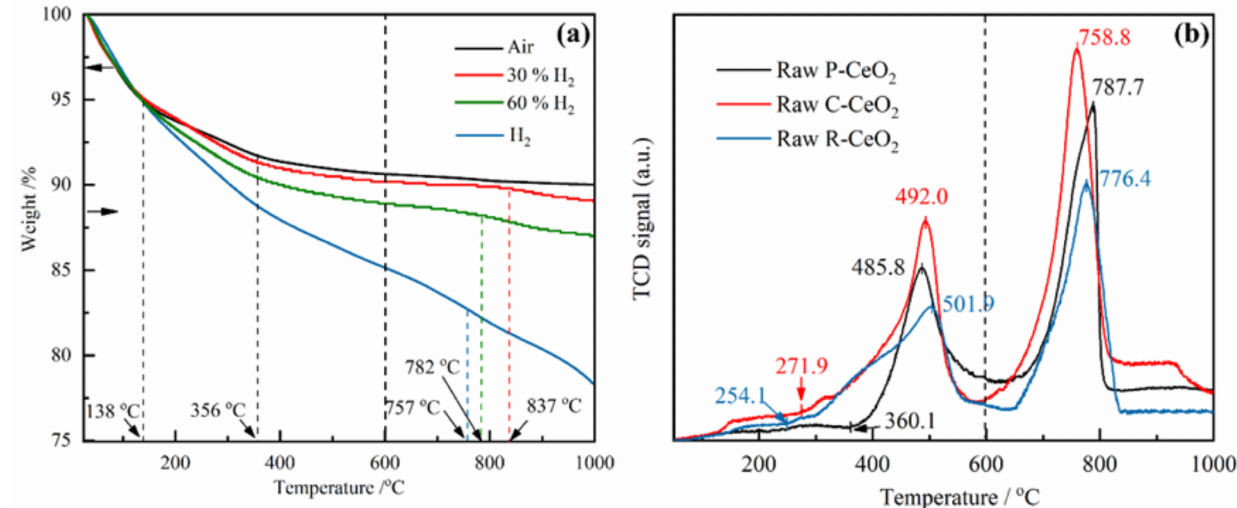
Figure 3. Thermal reduction behavior of synthesized ceria, ( a ) the thermo-gravimetric analysis of raw R-CeO 2 under different atmosphere, ( b ) the H 2 -TPR of raw P-CeO 2 , C-CeO 2 and R-CeO 2